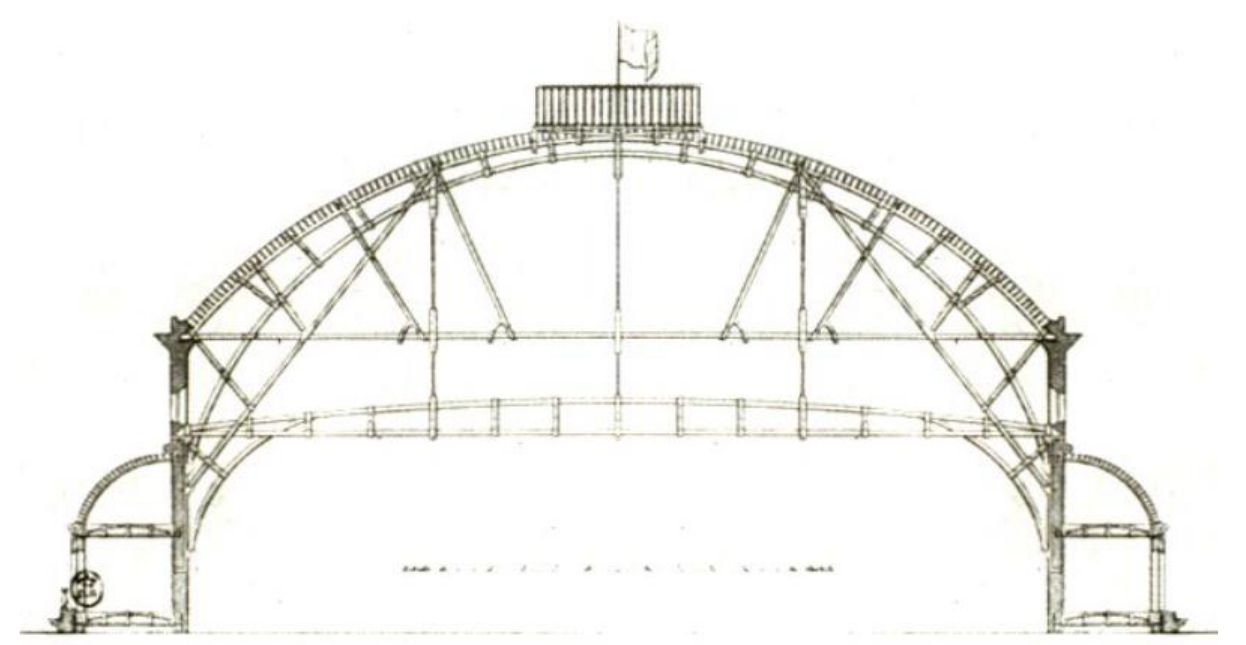
Figure 5. Structure of the roof of the French Theatre in Paris. Cross section through the glass dome, one of the first advances in the field of fire protection, by Victor Louis in Paris in 1786. Source: Giedion, Sigfried, Space, Time and Architecture. Cambridge: Harvard University Press, 1959, p. 172.